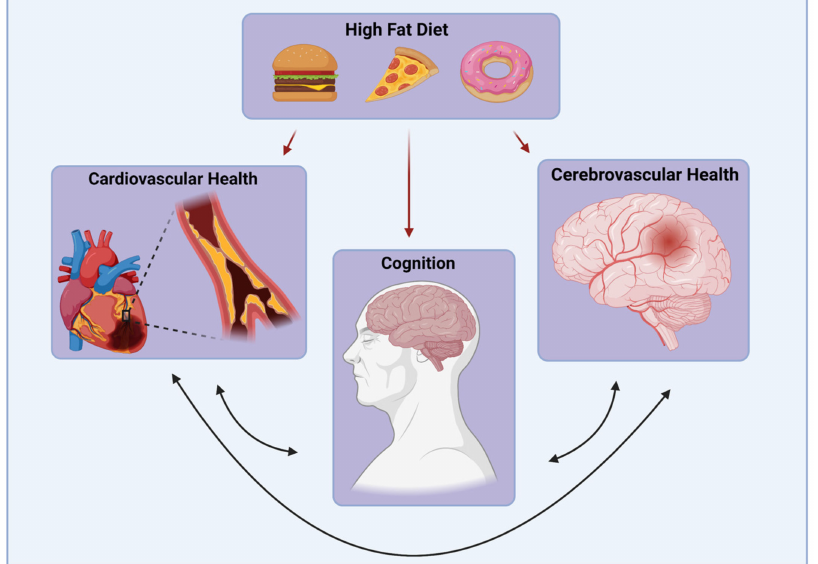
Figure 1. Detrimental Effects of an HFD. Consumption of an HFD can impair cardiovascular, cerebrovascular, and cognitive